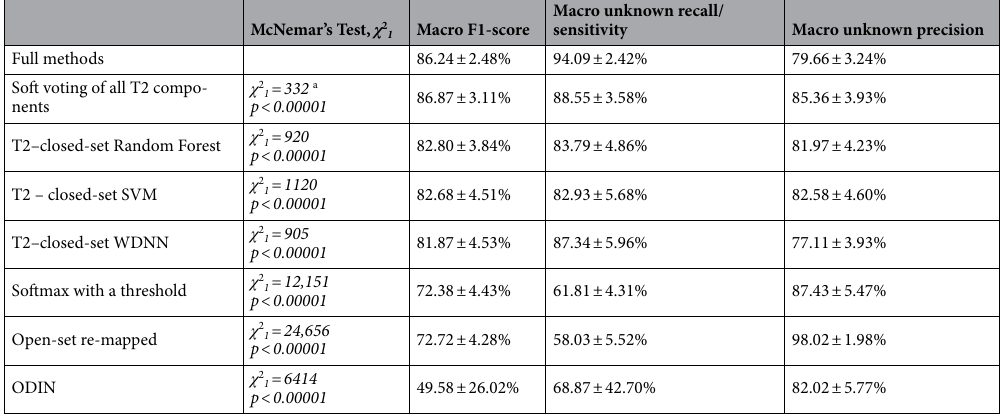
Table 3. Comparison of our methodology to simpler alternative methods. a A high chi-squared ( χ 2 1 ) value dictates a low p-value, which indicates a statistically significant difference with the full